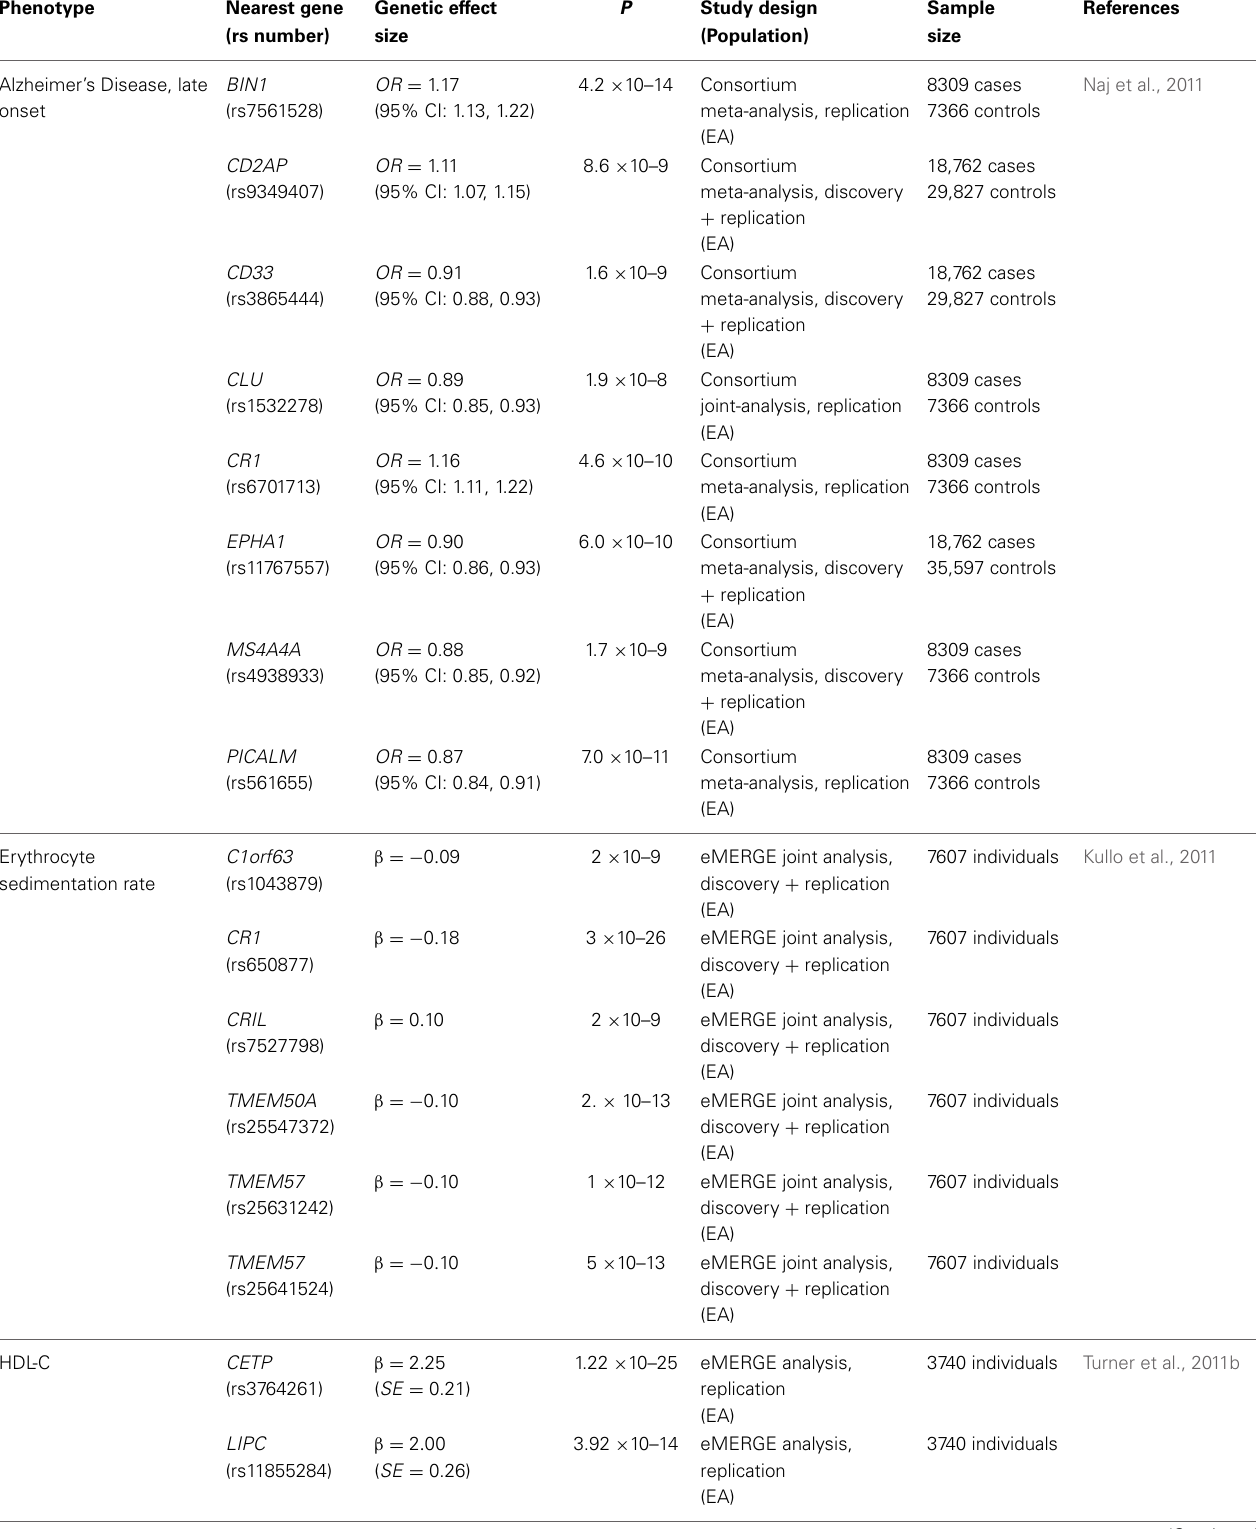
Table 1 | eMERGE and genomic